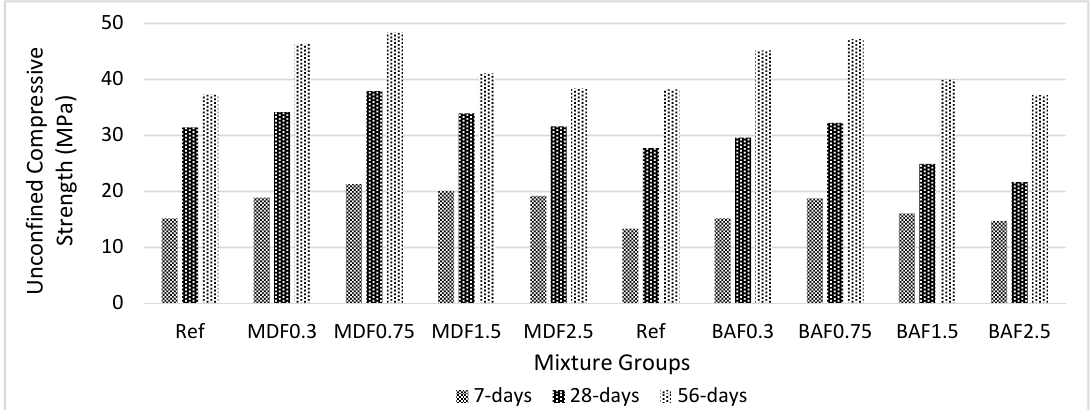
Figure 8. Effect of carbon fiber on unconfined compressive strength for marble dust and bottom ash mixture groups at 7, 28, and 56 days of curing.